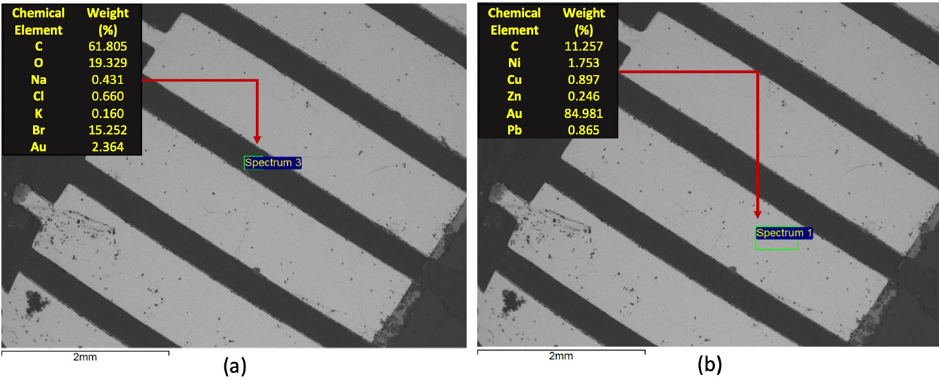
Figure 5. SEM/EDS characterization of Type 2 WEEE sample: ( a ) microanalysis of the dark area; ( b ) microanalysis of the bright area.